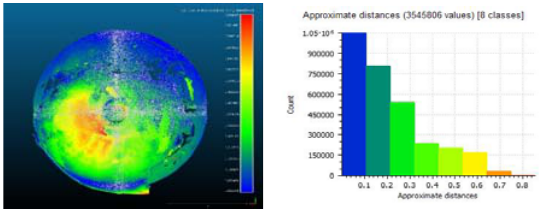
Figure 14: Discrepancy (m) map and histogram between the TLS point cloud and ODM processing.